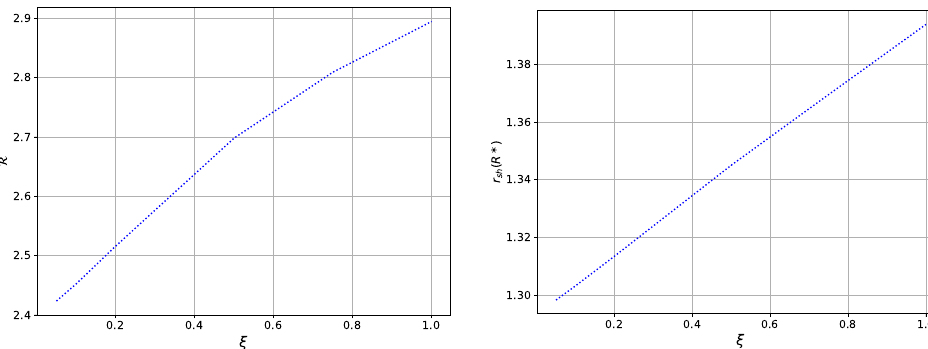
Figure 10. Variation of compression ratio R ( bottom left ) and shock location r sh ( bottom right ) with composition parameter ξ . whole range of ξ produces shock in the jet as the collimation is strong.